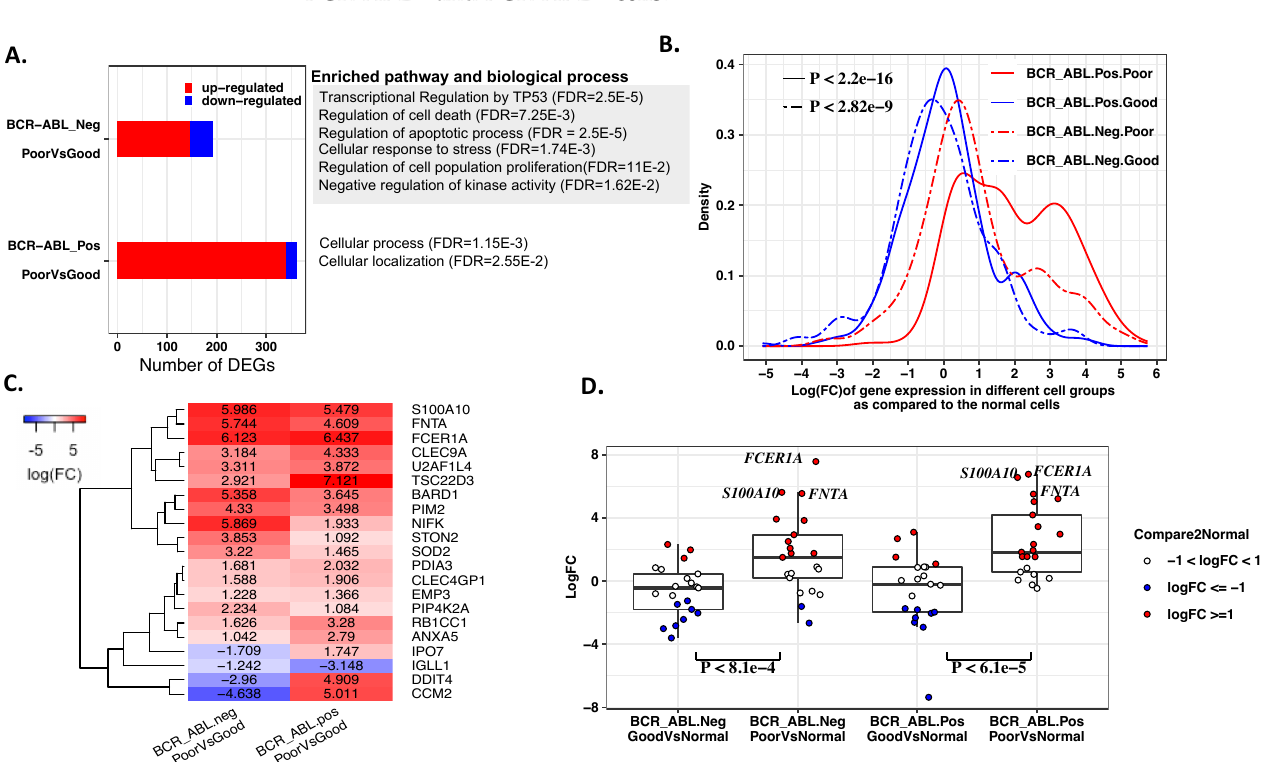
Figure 2. Comparisons of the stem cells from distinct TKI responders. ( A ) The gene expression markers that differentiate the cells of good and poor responders in BCR-ABL − and BCR-ABL + cell groups. Most gene markers were upregulated in the cells of poor responders. TKI response markers were enriched in multiple biological processes and pathways related to cancer development and drug resistance for the BCR-ABL − cell group, while similar function disruptions were not observed in BCR-ABL + stem cells. ( B ) The distribution of expression changes of the response gene markers in the individual cell groups as compared with the normal HSCs. The red curves correspond to expression change in the cells of the poor responders, while the blue curves are for good responders. ( C ) The major TKI response marker genes shared by BCR-ABL − and BCR-ABL + stem cells had higher expression in the cells of poor responders than good responders. ( D ) The expression changes of the common gene markers as compared to the normal HSCs. S100A10 , FCER1A , and FNTA had the largest expression increase in the cells of TKI poor responders. These genes showed more elevated expression levels in the both BCR-ABL + ( p < 6.1 × 10 − 5 ) and BCR-ABL − ( p < 8.1 × 10 − 4 ) stem cells from poor responders than from good